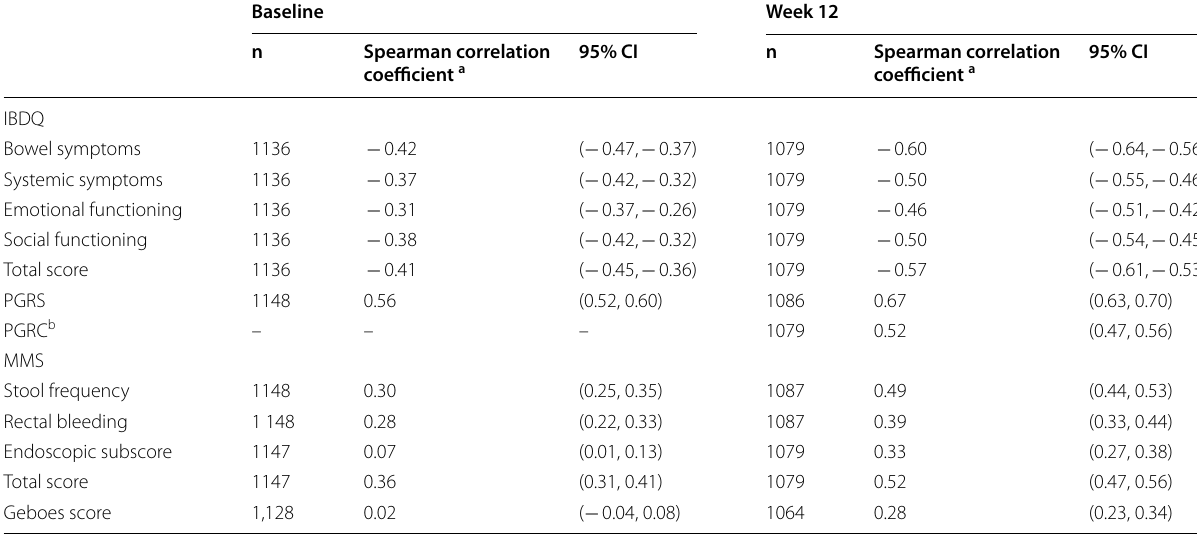
Table 4 Convergent and discriminant validity of the Urgency NRS at baseline and week 12